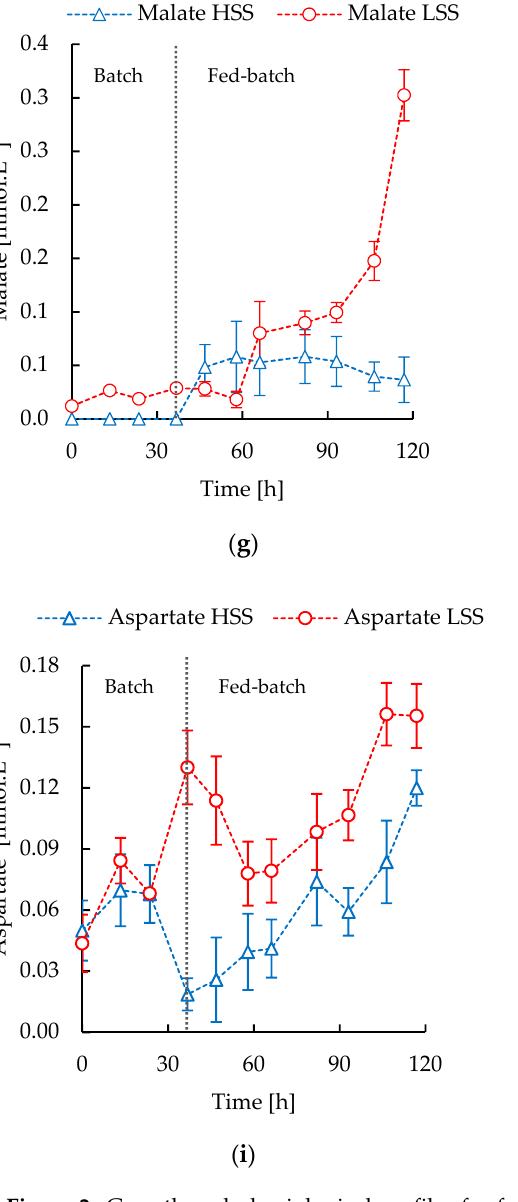
Figure 2. Growth and physiological profiles for fed-batch cultivations of S. clavuligerus under HSS (triangles, blue) and LSS (circles, red) conditions. ( a ) oxygen uptake (qO 2 ) and biomass; ( b ) Phosphate (Pi) and clavulanic acid (CA); ( c ) Glutamate and glycerol; ( d ) Pyruvate; ( e ) Succinate; ( f ) Oxaloacetate; ( g ) Malate; ( h ) Arginine; ( i ) Aspartate and ( j ) Asparagine and Glutamine. HSS: High shear stress and LSS: Low shear stress.